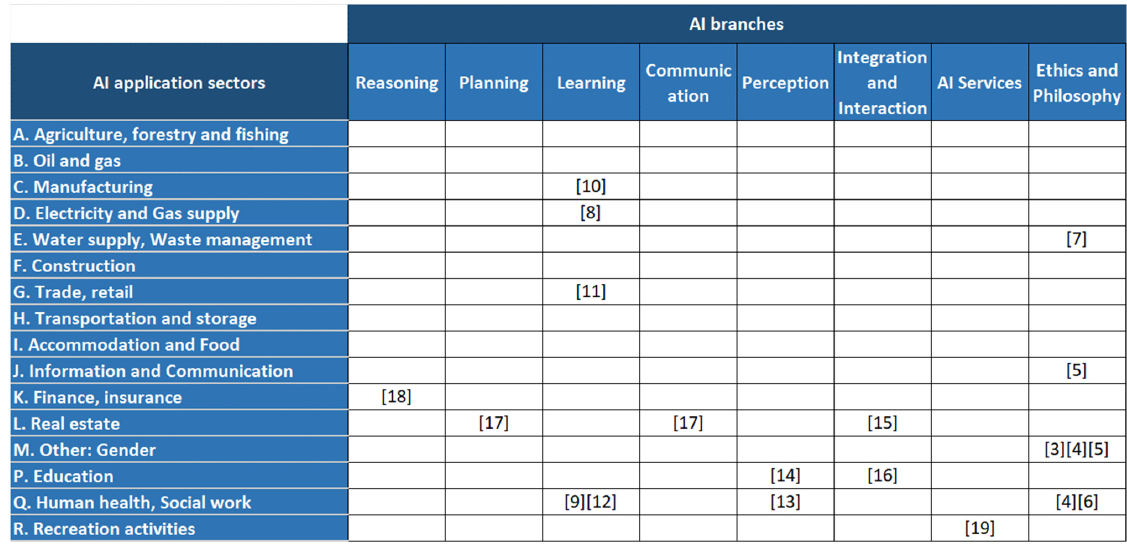
Figure 3. Classification of the papers regarding both AI branches and AI applications.